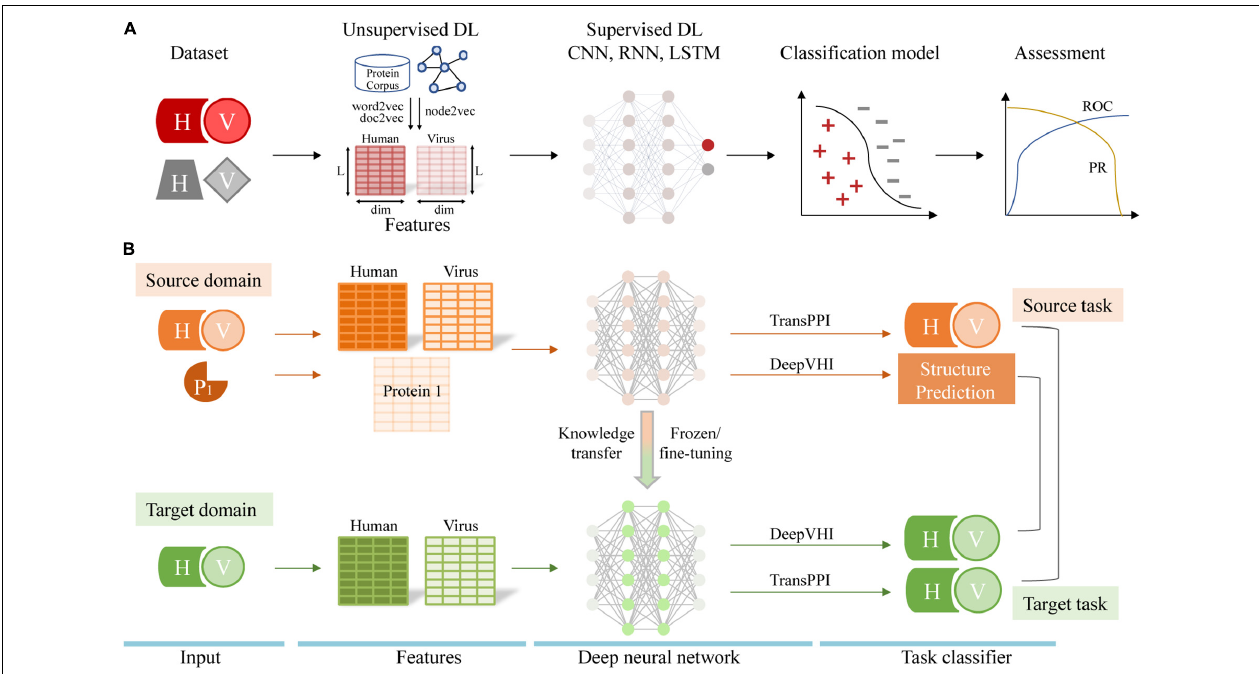
FIGURE 1 | (A) Workflow of human-virus PPI prediction covering dataset construction, feature engineering, model construction, and performance assessment. ROC indicates receiver operating characteristic curve and PR indicates precision-recall curve. (B) Transfer learning for the human-virus PPI prediction task. H, V, and P1 represents human protein, viral protein, and the single protein,